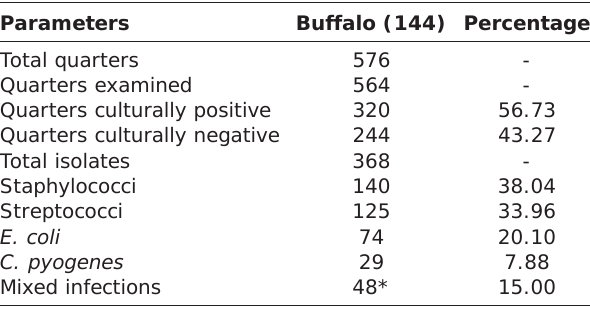
Table-1: Relative frequency of organisms isolated from 564 milk samples of 144 buffaloes.